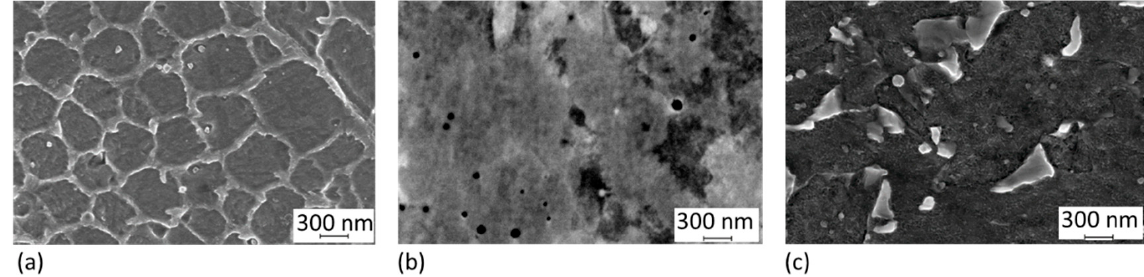
Figure 8. Detail SEM images of MS1 steel in: ( a ) as ‐ built condition etched, observed in secondary electrons; ( b ) as ‐ built condition polished, observed in back ‐ scattered electrons; ( c ) precipitation hardened condition.